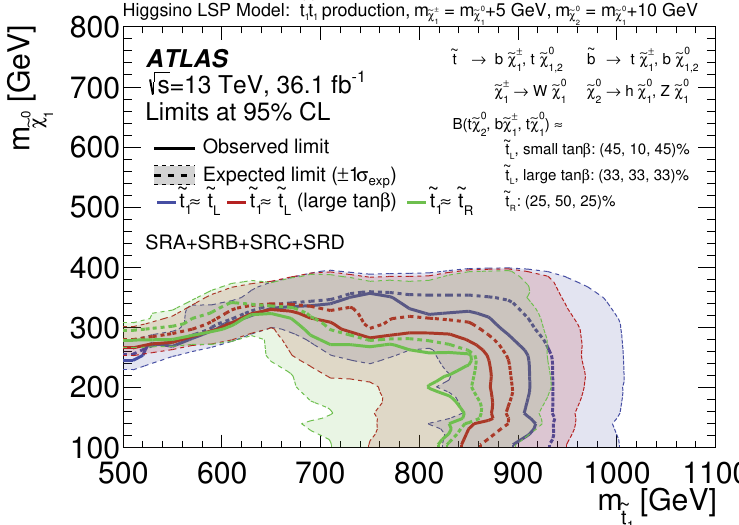
Figure 10. Observed (solid line) and expected (dashed line) exclusion contours at 95% CL as a function of m ~ and m for the pMSSM-inspired non-asymptotic higgsino simpli(cid:12)ed model for a t 1 ~ (cid:31) 0 1 small tan (cid:12) with B (~ t 1 ! t ~ (cid:31) 0 2 , ~ t 1 ! t ~ (cid:31) 0 1 , ~ t 1 ! b ~ (cid:31) (cid:6) 1 ) = 45%, 10%, 45% (blue), a large tan (cid:12) with B (~ t 1 ! t ~ (cid:31) 0 2 , ~ t 1 ! t ~ (cid:31) 0 1 , ~ t 1 ! b ~ (cid:31) (cid:6) 1 ) = 33%, 33%, 33% (red), and a small ~ t R with B (~ t 1 ! t ~ (cid:31) 0 2 , ~ t ! t ~ (cid:31) 0 1 , ~ t ! b ~ (cid:31) (cid:6) 1 ) = 25%, 50%, 25% (green) assumption. Uncertainty bands correspond to the 1 1 (cid:6) 1 (cid:27) variation of the expected limit.